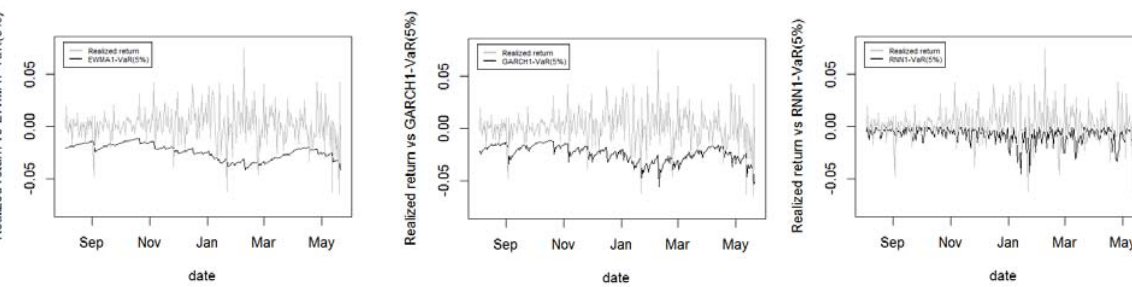
Figure A10. Out of sample realized return vs. 1 day ahead VaR (5%) of EWMA, GARCH and RNN Figure 10. Out of sample realized return vs 1 day ahead VaR(5%) of EWMA, GARCH and RNN model